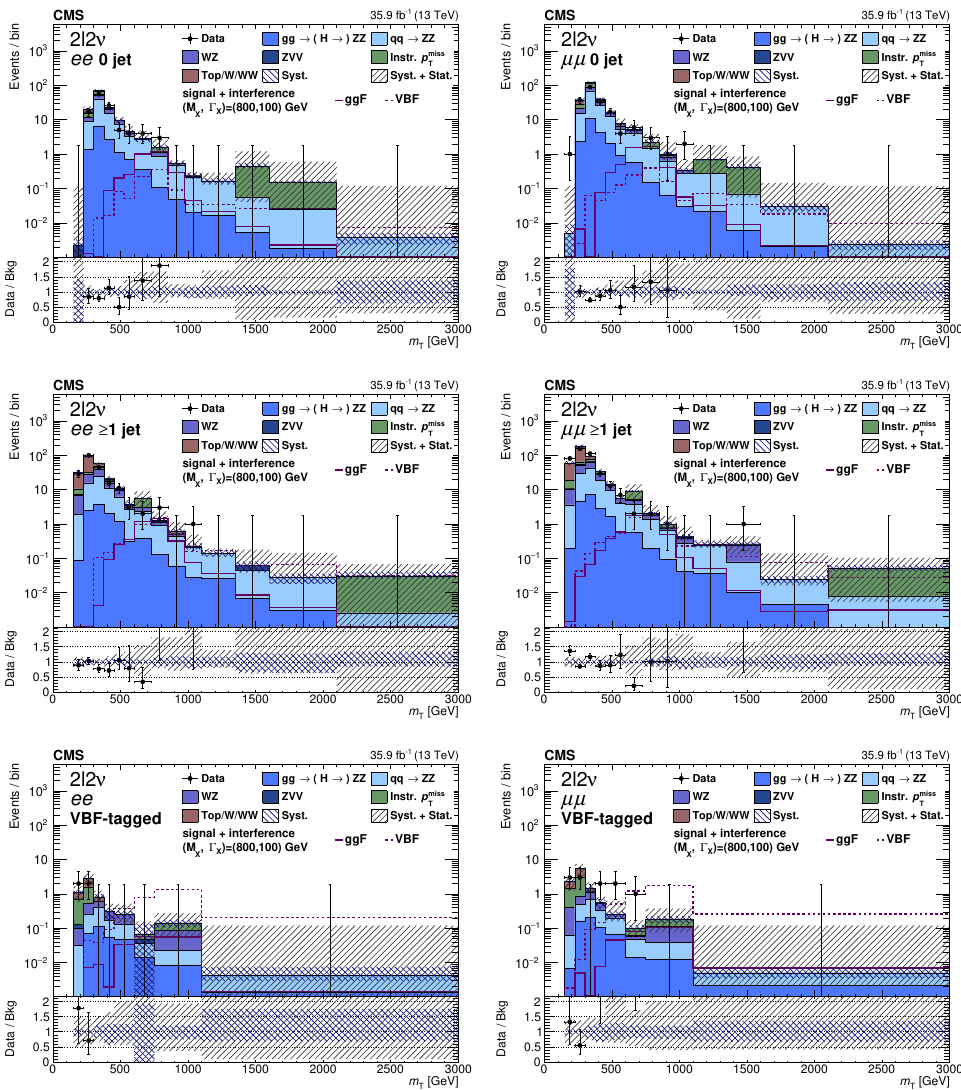
Figure 6 . Distributions of the transverse mass m T in the signal region for the di(cid:11)erent analysis categories for the 2 ‘ 2 (cid:23) channel, in the ee(left) and (cid:22)(cid:22) (cid:12)nal states (right). The points represent the data and the stacked histograms the expected background. The open histograms show the expected gluon fusion and VBF signals for the product of cross section and branching fraction equal to (cid:27) (pp ! H ! ZZ) = 50 fb. Lower panels show the ratio of data to the expected background. The shaded areas show the systematic and total combined statistical and systematic uncertainties in the background